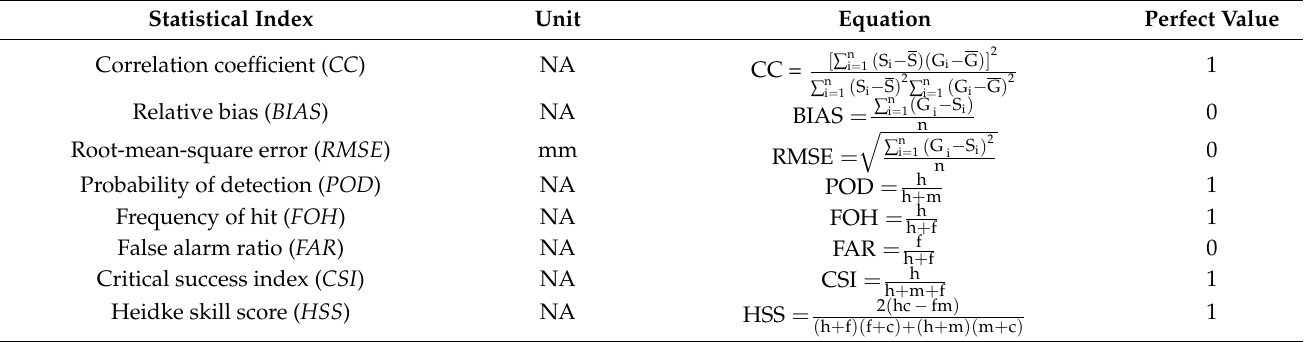
Table 3. List of the statistical indexes used to quantify the performance of the satellite rainfall products statistical